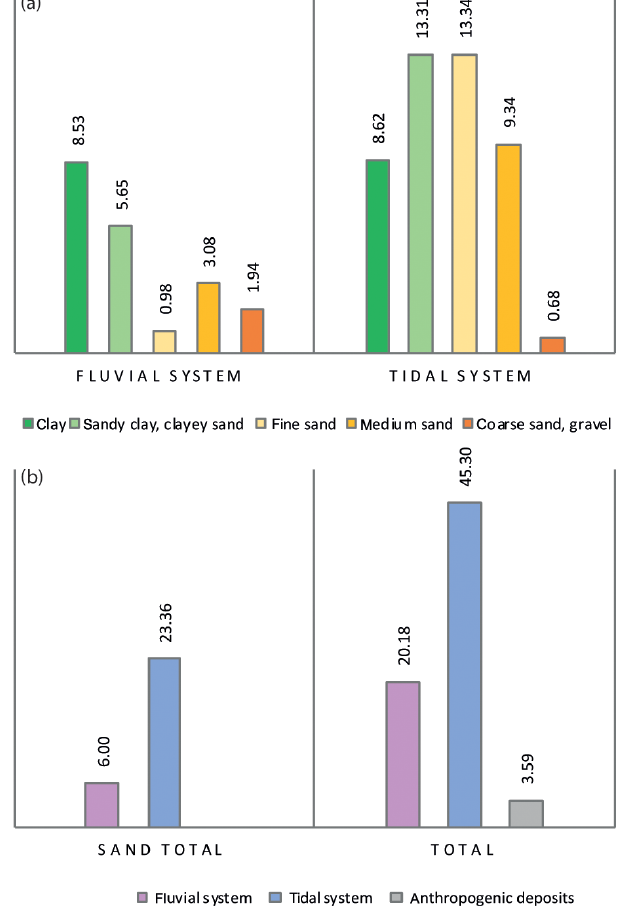
Figure 3. (a) Summary of the lithology of the sediments delivered by the fluvial Rhine system and the tidal systems. (b) Accumu- lated sand and total sediments brought by both systems and anthro- pogenic deposits.